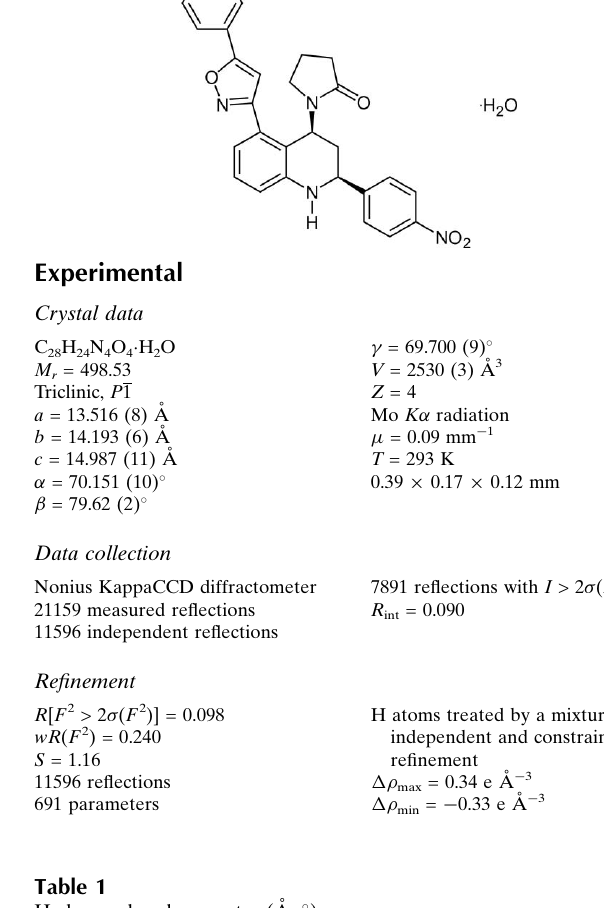
Hydrogen-bond geometry (A˚ , (cid:3)